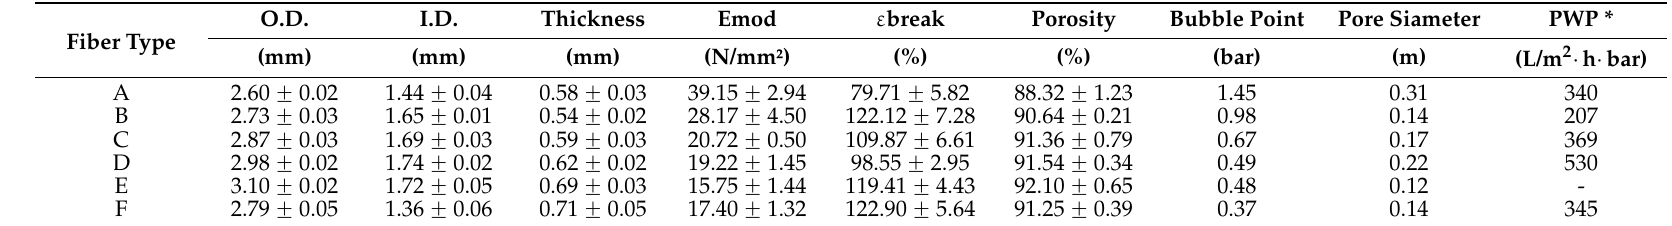
Table 2. Main properties of PVDF hollow